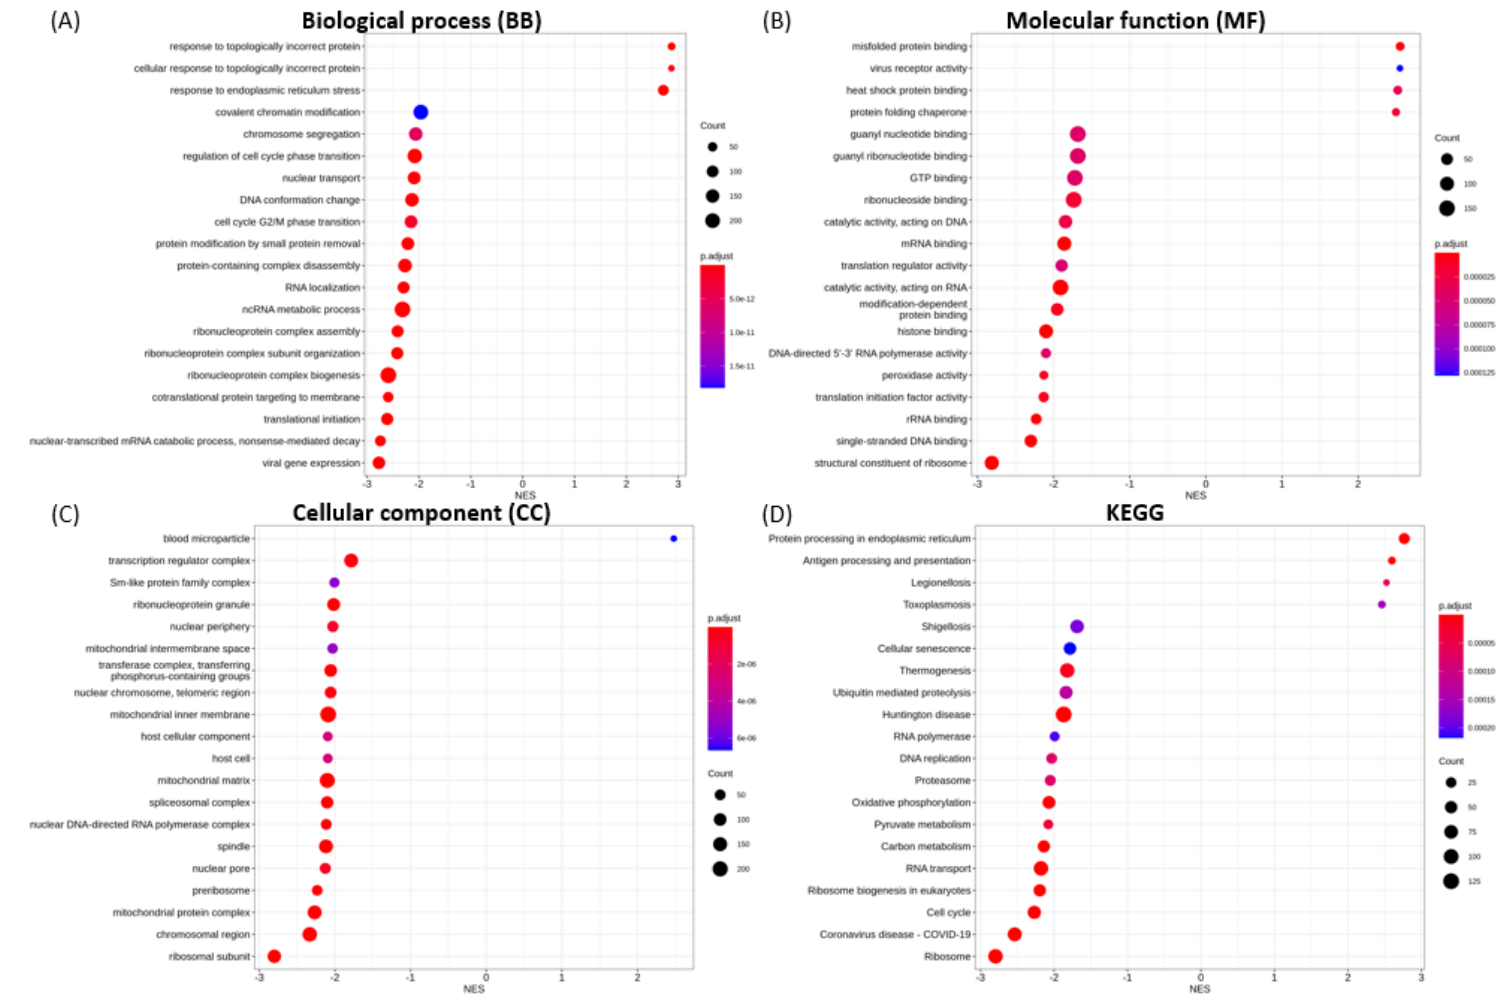
Figure 4. GSEA enrichment for SARS-CoV-2 spike S1 transfection illustrating the top 20 most significantly enriched terms for ( A ) BP, ( B ) MF, ( C ) CC and ( D ) KEGG pathways, in decreasing order based on normalized enrichment score